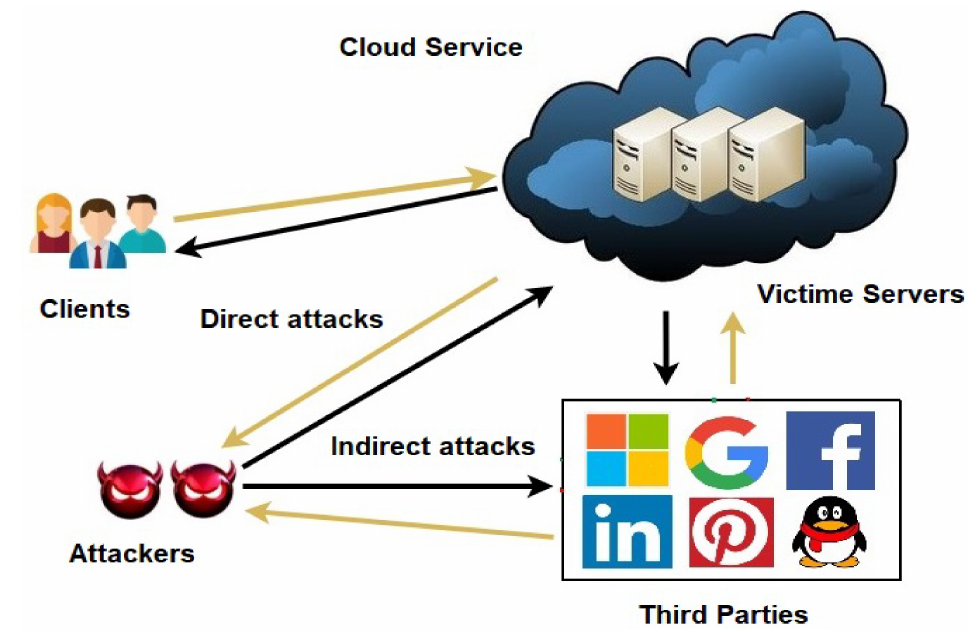
Figure 1. Economic denial of sustainability threat to cloud computing service